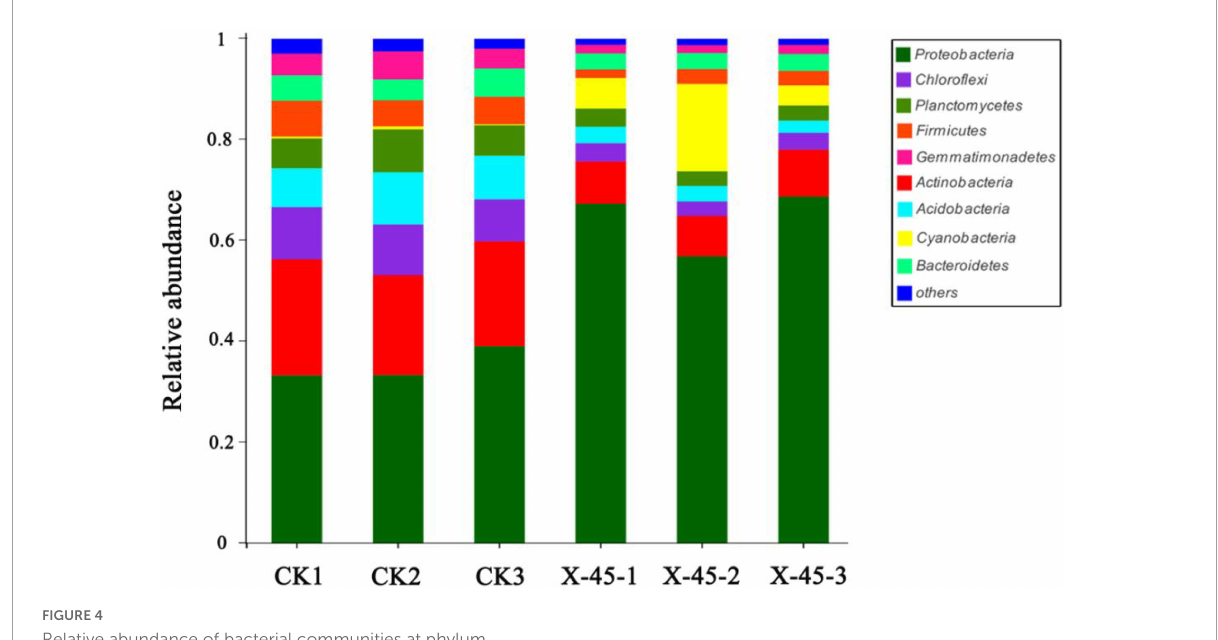
FIGURE4 Relative abundance of bacterial communities at phylum.